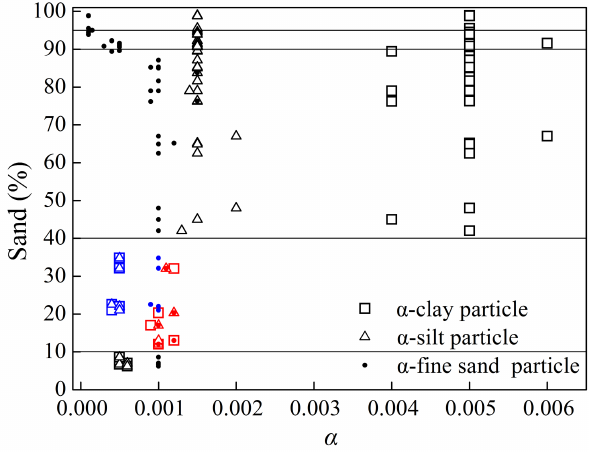
Figure 4. The α values for 48 soil samples with different sand con- tent. The α values for clay, silt, and fine sand particles of specific samples are listed in Fig. 4, except those of the coarse sand parti- cle, which are the same value of 0.0004 for all of the samples. For the samples with sand content ranging from 10% to 40%, two sets of α value are observed. The α values for the silt content less than and more than 50% are highlighted in red and blue, respectively, thereby reflecting the dominant functions of the silt or clay particle on the hydraulic properties of typical